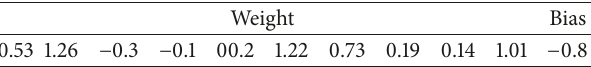
Table 26: Weight and bias value for hidden